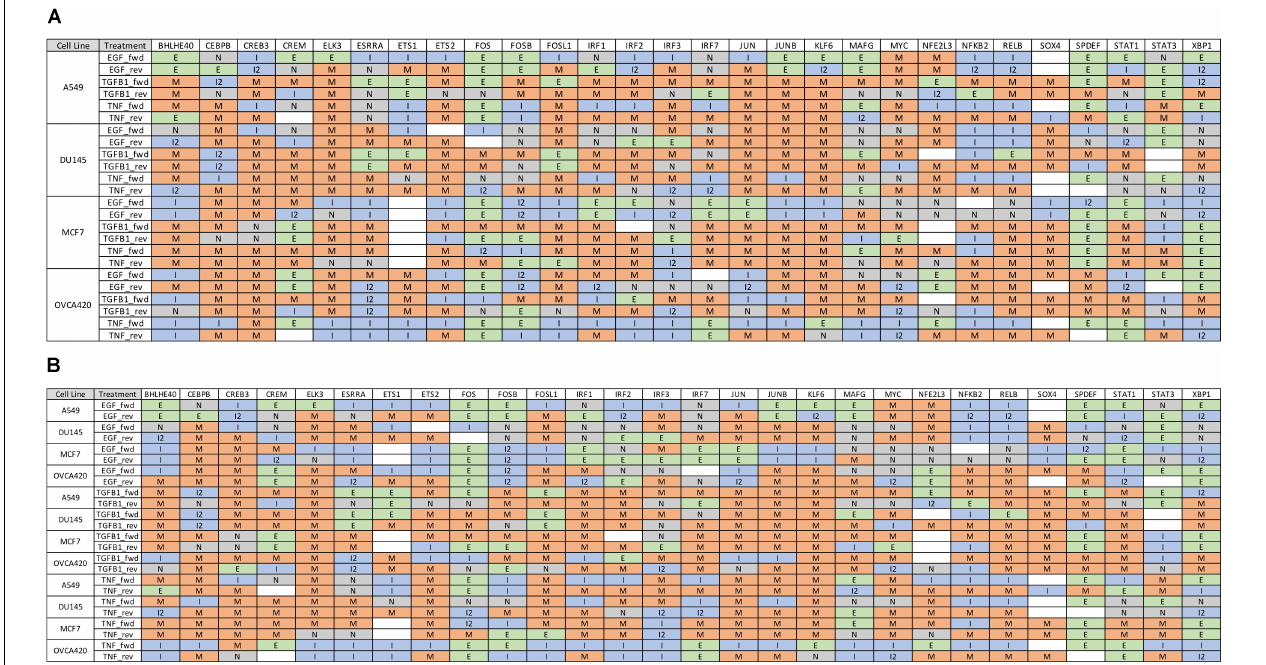
FIGURE 3 | Gene expression time dynamics of common TFs for forward and backward transitions. (A) Table of the most common 28 TFs with state classifications sorted by cell line. While many genes play similar roles across all datasets, some, such as SPDEF and IRF3, show cell-line dependent behaviors. (B) 28 most common TFs with state classifications sorted by signal. As in (A) , some genes such as STAT1 and NFKB appear to play different roles in EMT according to the inducing